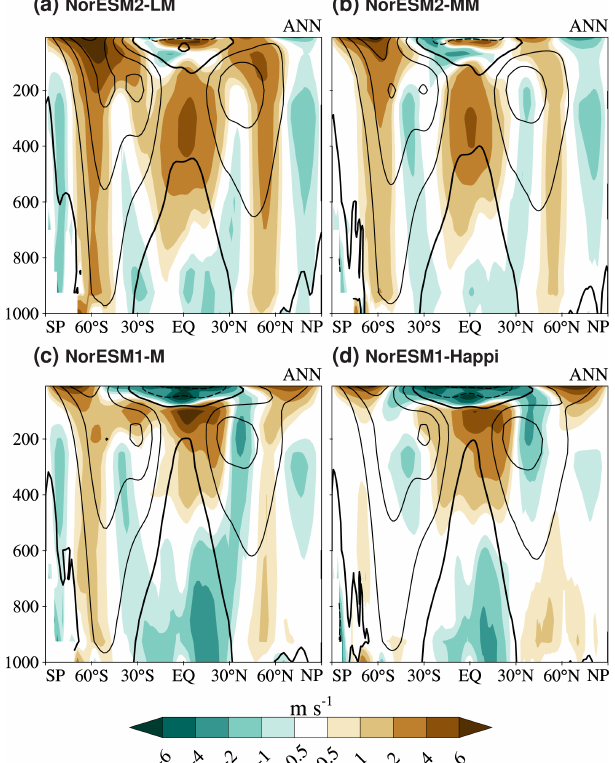
Figure 15. Annual-mean ensemble-mean model bias for temper- ature (colours) shown with the present-day model climatology (solid black contours; values from 210K to 285K by 15K) from Table 3. Summary of Carbon fluxes and stocks. Fluxes of gross primary production (GPP; PgCyr − 1 ), and soil and vegetation car- bon stocks (PgC). Data are averaged over the period 1995–2014 for NorESM2 (MM and LM) and 1982–2005 for NorESM1 (Tjipu- tra et al., 2013). Observational data for GPP are from FLUXNET- MTE (Jung et al., 2011), for soil C from the Harmonized World Soil Database (Fao/Iiasa/Isric/Isscas/Jrc, 2012) and veg. C from GEO- CARBON project (Avitabile et al., 2016; Santoro et al., 2015), are all available from http://ILAMB.org (last access: 8 June 2020).